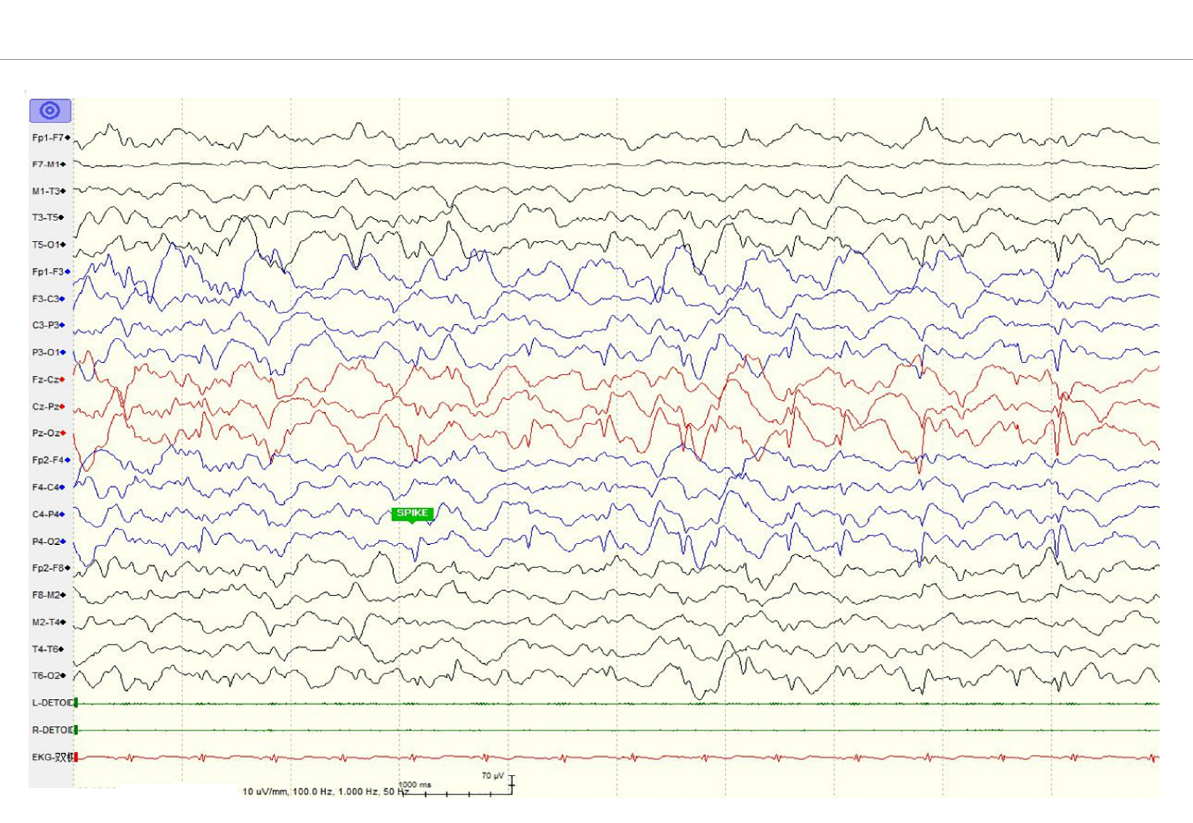
FIGURE2 Electroencephalogram of the patient showed only scarce sharp waves during sleep at age seven after anti-epileptic drug